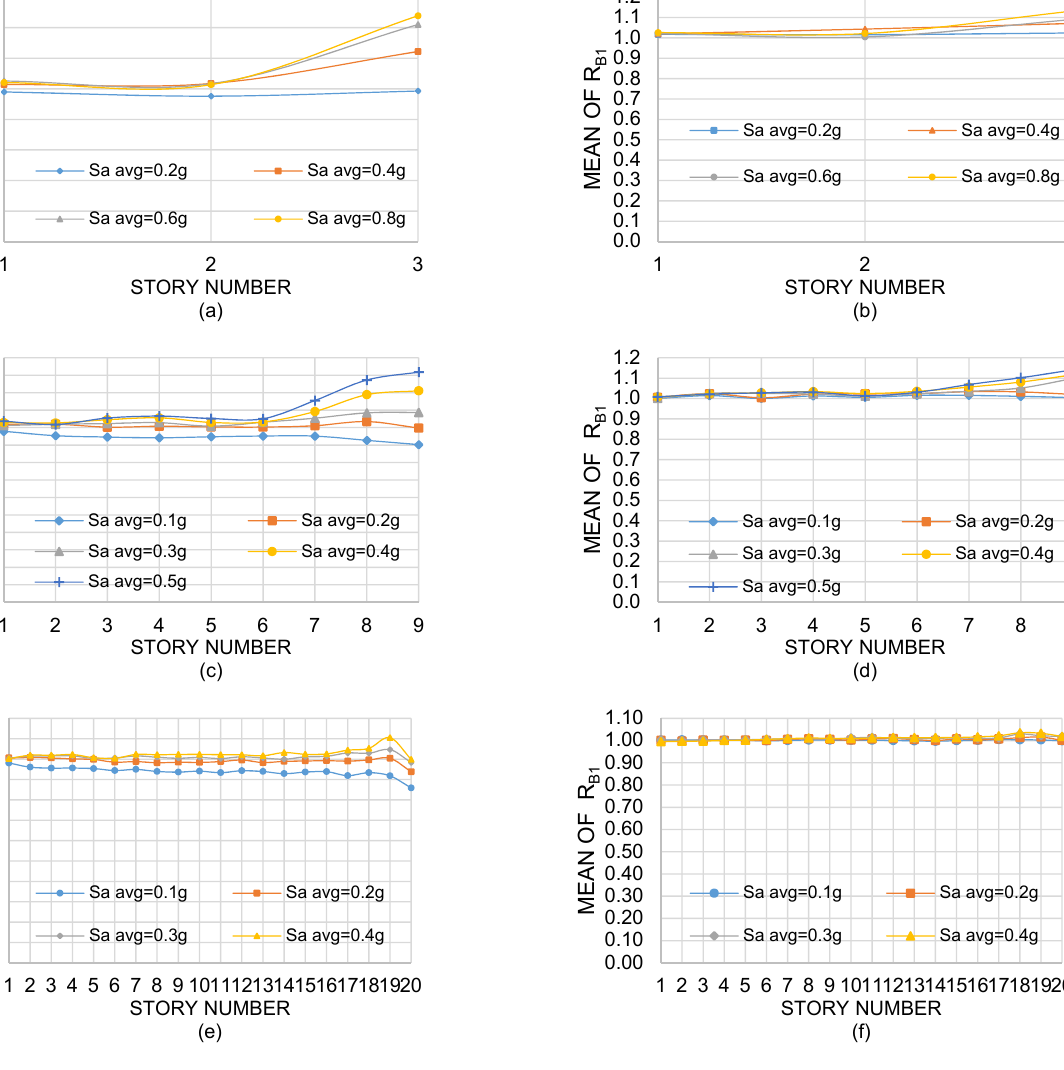
Figure 12. Mean values of R B 1 , NS : ( a , c , e ), exterior columns of Models 1, 2 and 3, respectively; ( b , d , f ), interior columns of Models 1, 2 and 3, respectively.